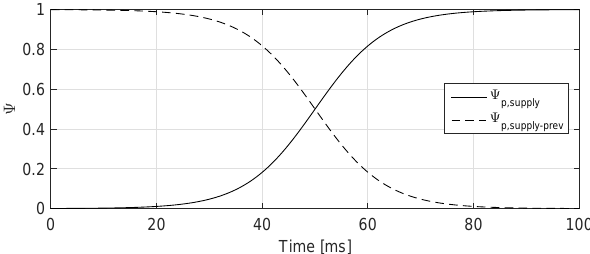
Figure 14: Hyperbolic tangent switching functions used for switching between pressure lines.